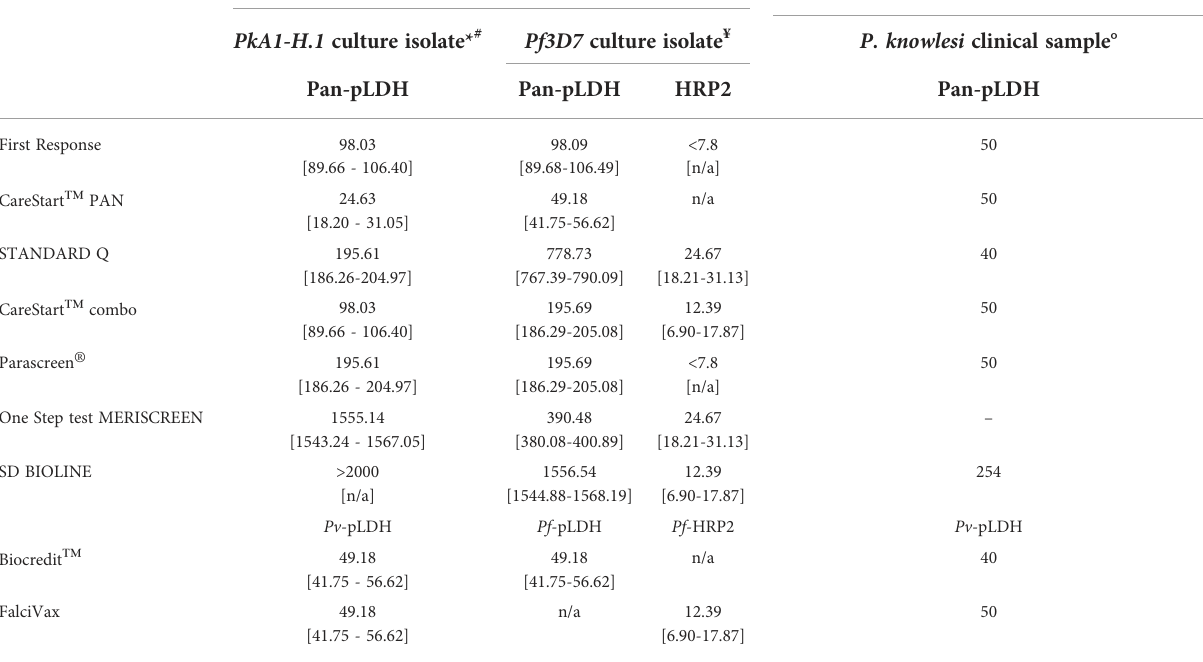
TABLE 3 Limit of detection (LoD) for nine rapid diagnostic